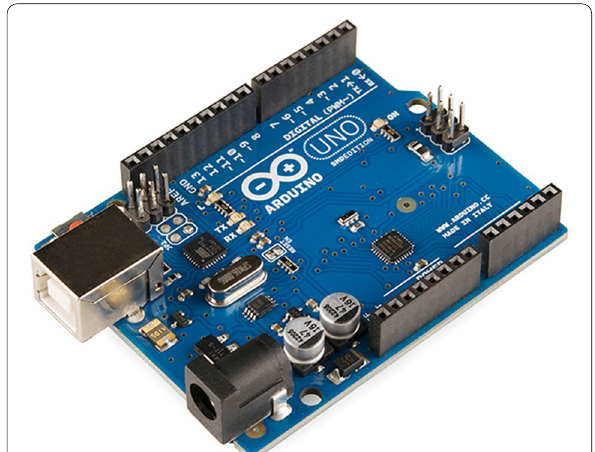
Fig. 1 The Arduino UNO is a popular and inexpensive open-source microcontroller board based on the ATmega328P microcontroller. The board features 14 digital pins and 6 analog input pins (featuring 10-bit ADC resolution). Also, 6 of the 14 digital pins can be configured as pseudo-analog output pins, with the analog outputs being simulated using PWM (pulse width modulation). The Arduino UNO